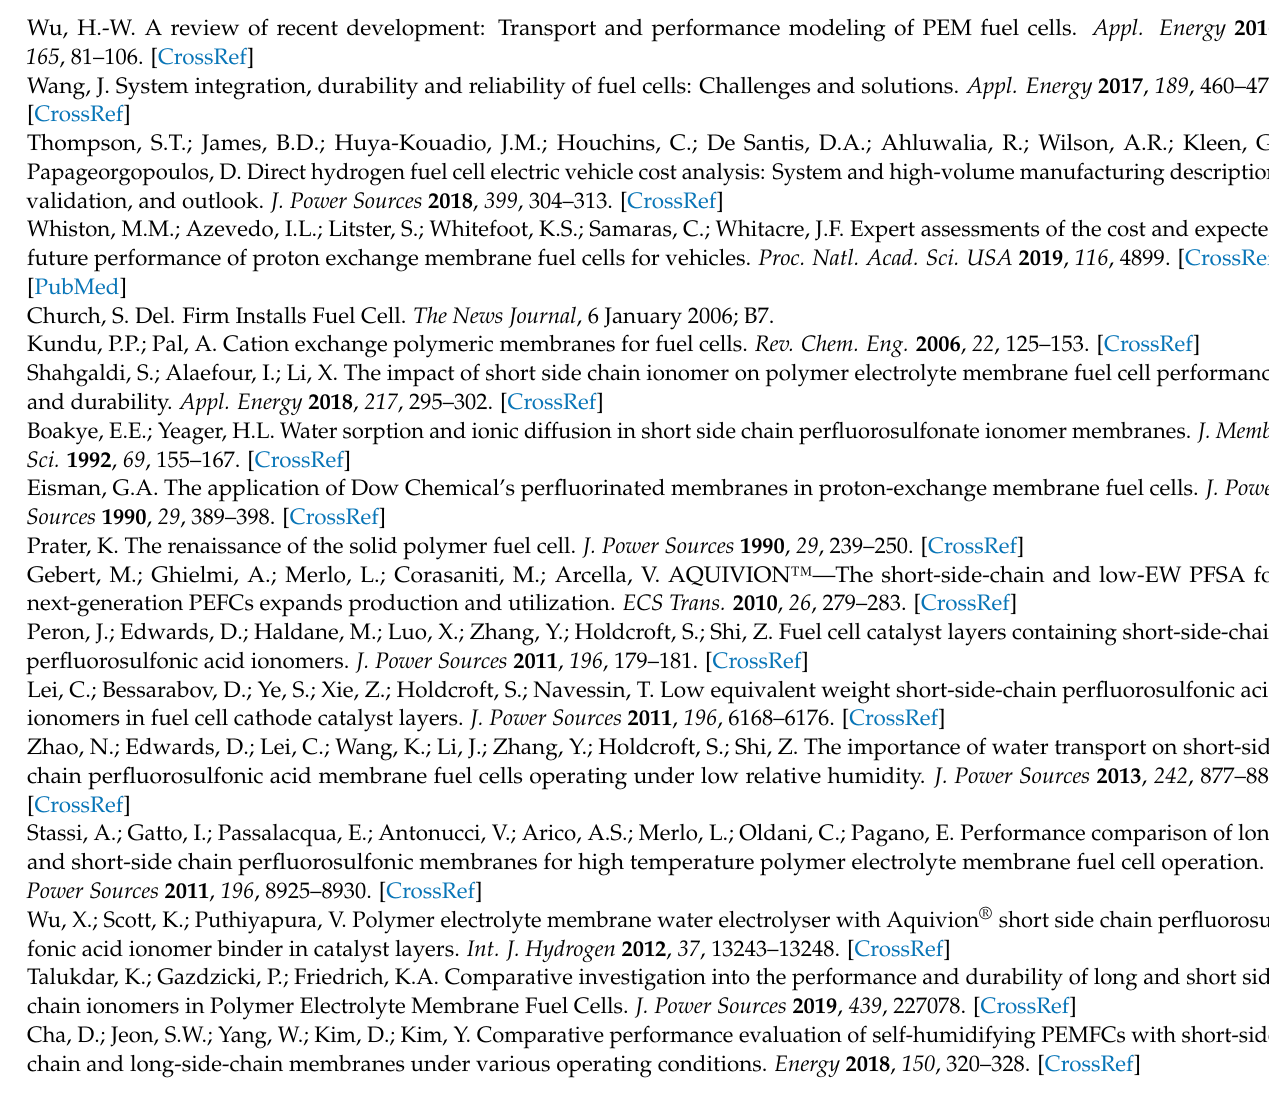
Figure S2: iR -compensated PLs for all the MEAs at 80 ◦ C and various RH. Method: In-situ